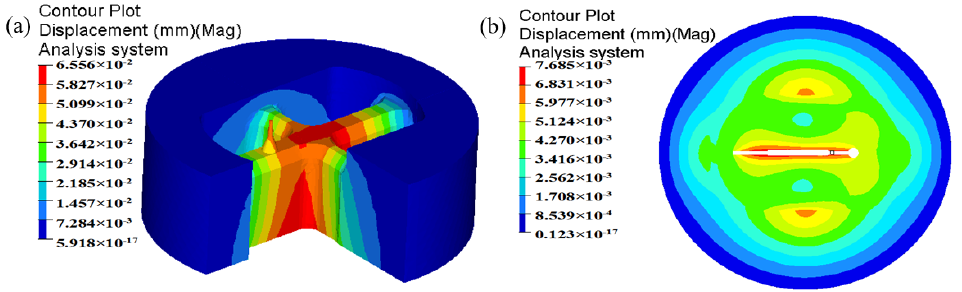
Figure 9. Displacement distribution of the first modification scheme: ( a ) the upper die and ( b ) the lower die.